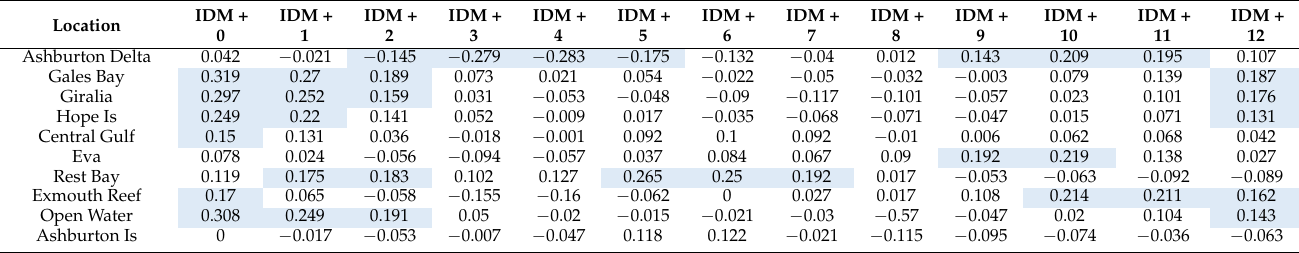
Table A3. Pearson’s r correlations between turbidity and the Indian Ocean Dipole mode (IDM) at different time lags. Highlighted cells indicate significant correlations ( p <